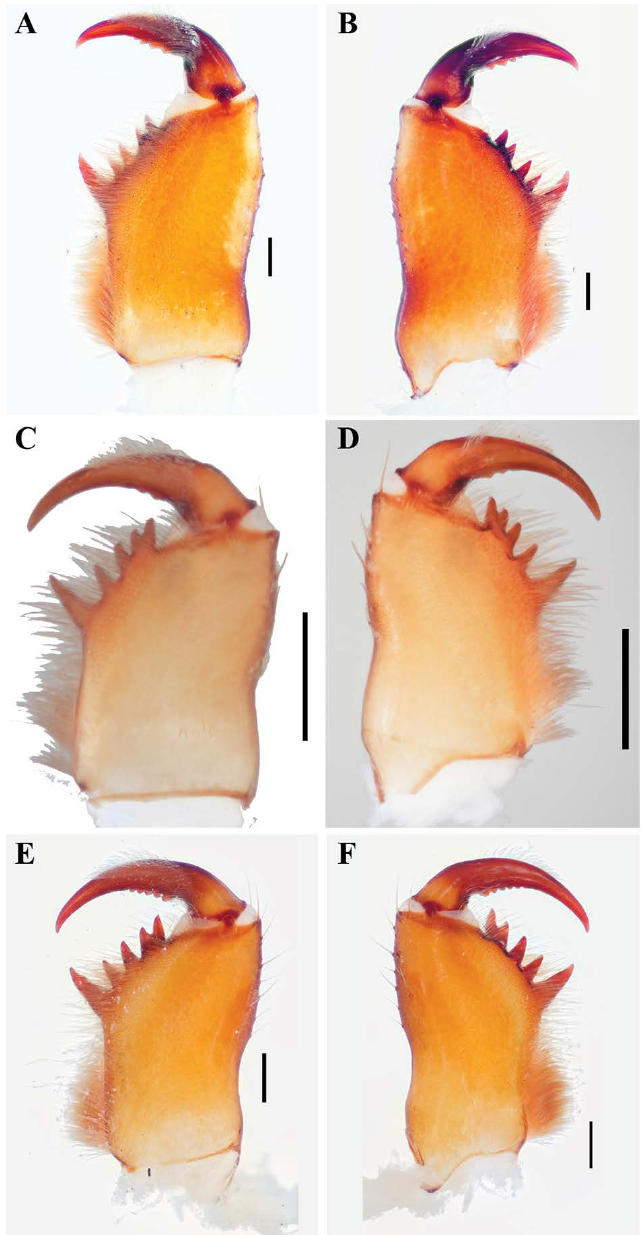
Fig. 11. Charinidae Quintero, 1986, chelicerae, prolateral and retrolateral views. A–B . Charinus milloti Fage, 1939 (MNHN). C–D . Sarax cochinensis (Gravely, 1915) (AMCC [LP 13118]). E–F . Charinus longipes Weygoldt, 2006 (MNHN). Scale bars: